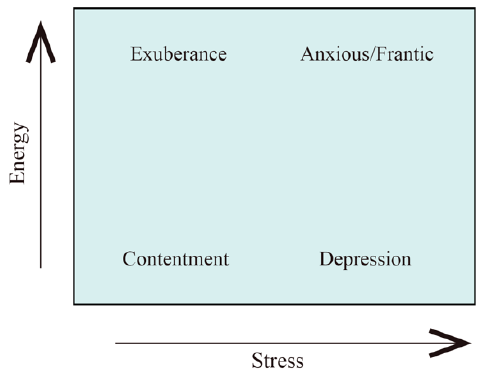
Figure 2. Thayer’s model. The Thayer’s model is proposed by Robert E. Thayer. In the model, emotional states are represented by energy and stress corresponding to arousal and valence of the circumplex model. Energy refers to the volume or intensity of sound in music and Stress refers to the tonality and tempo of music. The mood is divided into four clusters: calm-energy (e.g., Exuberance), calm-tiredness (e.g., Contentment), tense-energy (e.g., Frantic) and tense-tiredness (e.g., depression). Using the Thayer’s model, it is possible to characterize musical passages according to the dimensions of energy and stress.